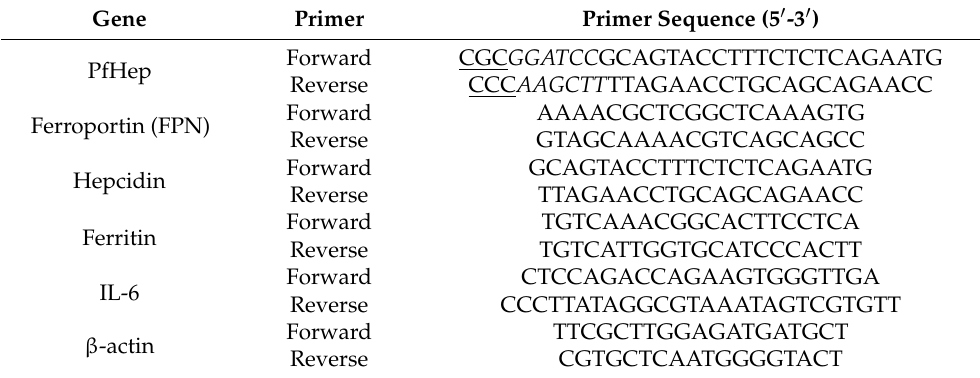
Table 1. Primer sequences used for PCR.